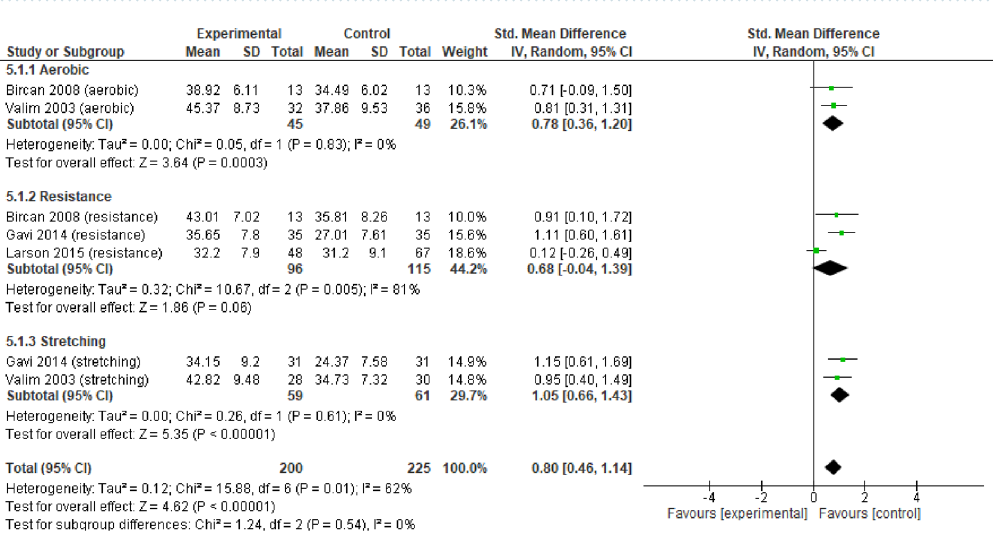
Figure 7. Forest plots showing the effect of training on the Mental Component of HRQOL outcomes.